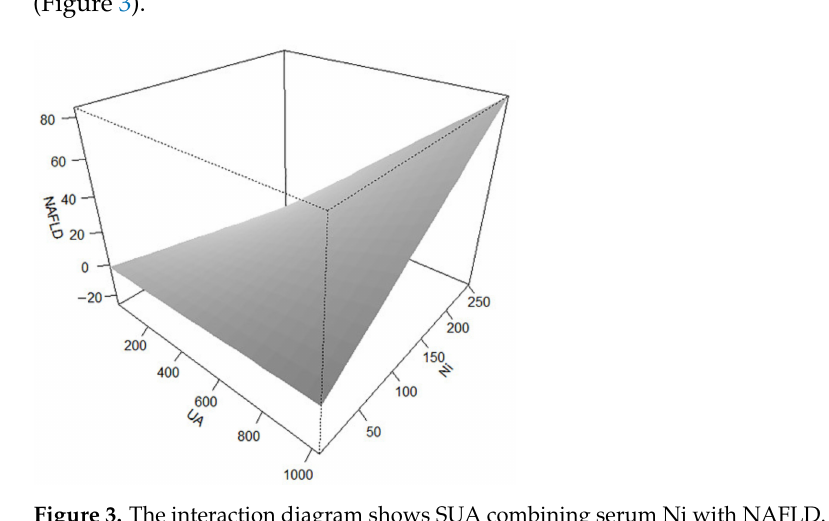
Figure 3. The interaction diagram shows SUA combining serum Ni with NAFLD. SUA and serum Ni are regarded as continuous variables.